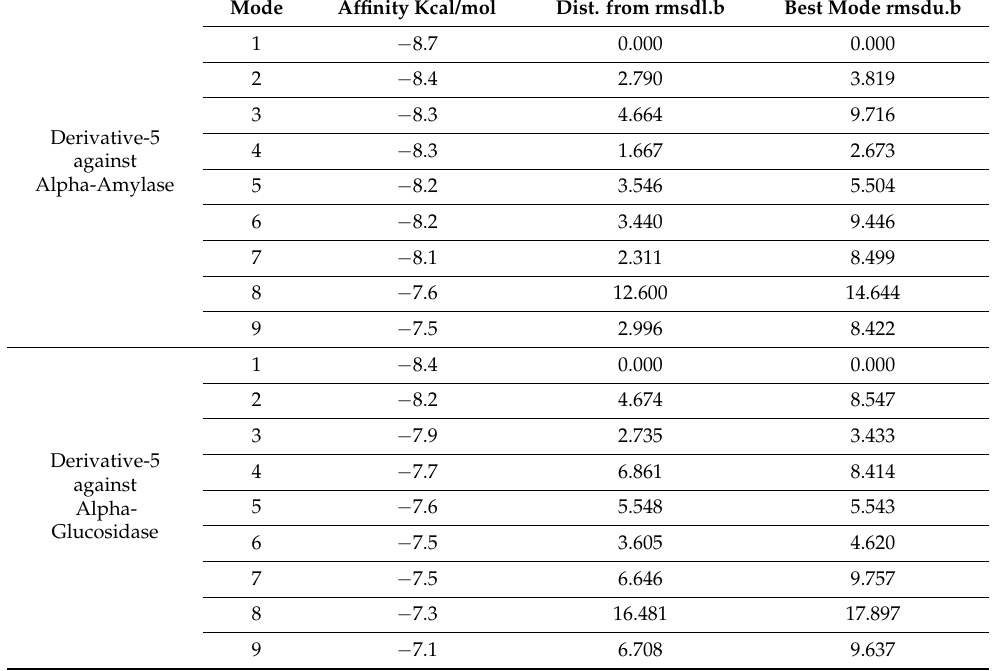
Table 3. Represent the binding affinities and best mode RMSD of analog 5 against Alpha-amylase and